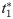
Each plot shows one network output unit’s responses to all 2818 presentations of lny64’s song shown in Fig 1.We show only the syllables t1*, t4*, and t6*, and we do not show the non-response to presentation of non-song. The horizontal axis is time relative to the beginning of the aligned song, and the vertical axis is an index for the 2818 individual song presentations. The grey shading shows the audio amplitude of song Y at time T. Detection events on training songs are shown in cyan, with detections of unseen test songs in red. To provide an intuition of intra-song variability, songs have been stably sorted by the time of detection events; thus, each of the three detection graphs shows the songs in a different order.